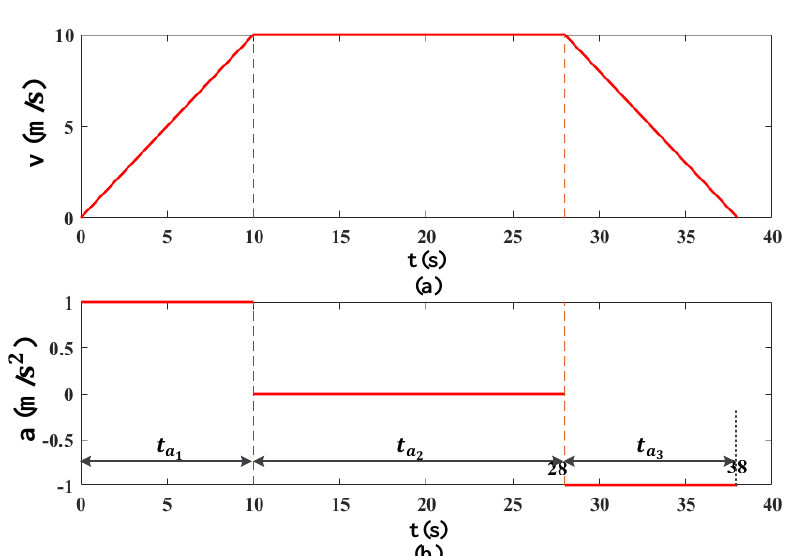
Figure 5. Elevator speed curve ( a ) and acceleration curve ( b ).